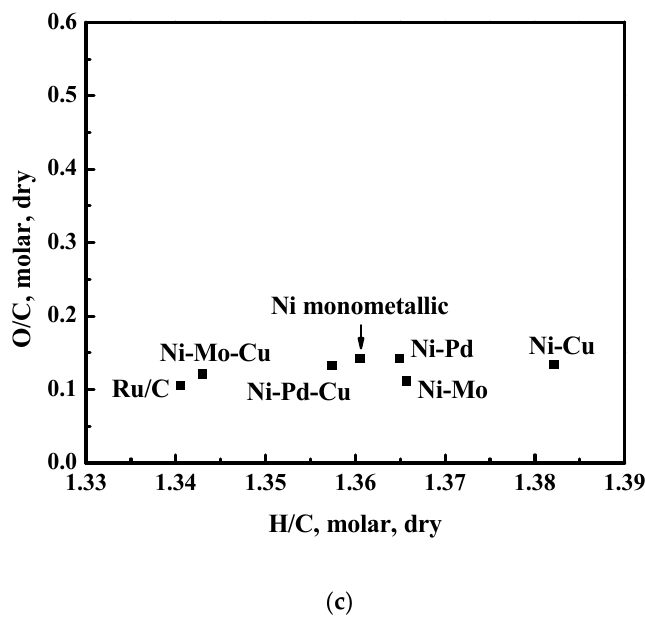
Figure 2. The van Krevelen plot for PS, PL feeds and hydrogenated products oils after catalytic hydrotreatment reaction using nickel based catalysts and Ru/C at 350 °C in 4 h: ( a ) overview, ( b ) PS and hydrogenated oils, ( c ) magnified part of Figure 2a (hydrogenated PL oils).